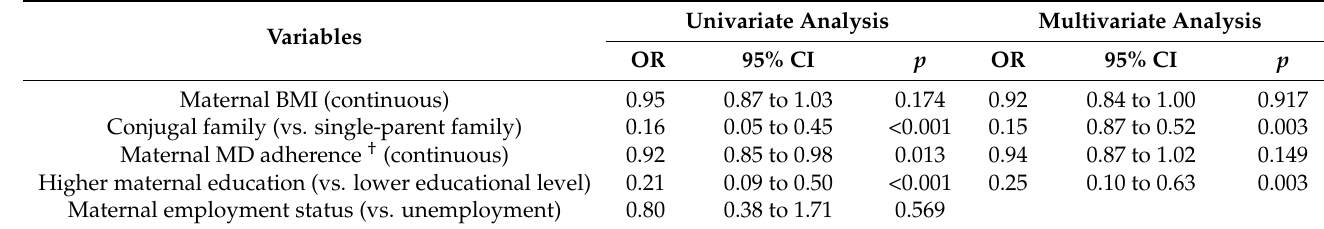
Table 6. Univariate and multivariate logistic regression models explaining household